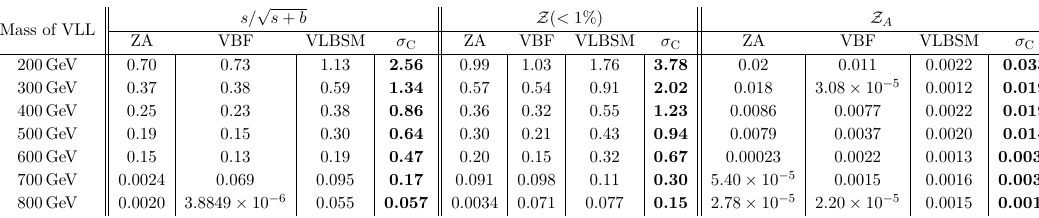
Table 6. Signal significance for the lightest VLL. The computation follows an evolutive algorithm that maximizes the Asimov significance metric. All significances are computed for L = 3000 fb − 1 √ s = 14 TeV. σ C is the combined significance as defined in (5.4). with centre-of-mass energy of Mass of VLL